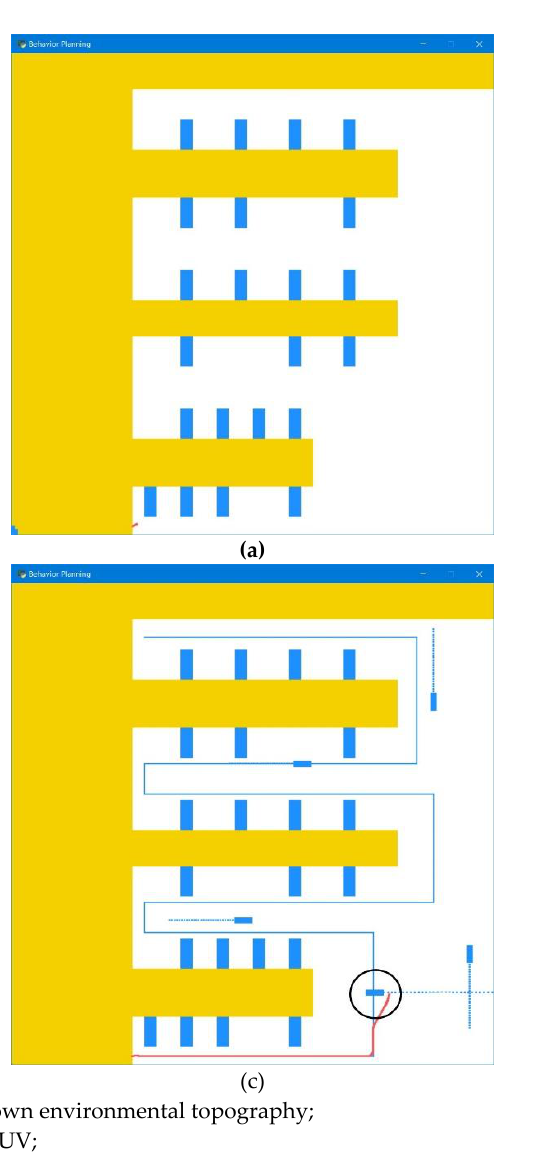
Figure 9. Motion planning of patrolling in harbor waters. ( a ) marine environment, ( b ) global planning, ( c ) path following and obstacle avoidance, ( d ) end of the test.